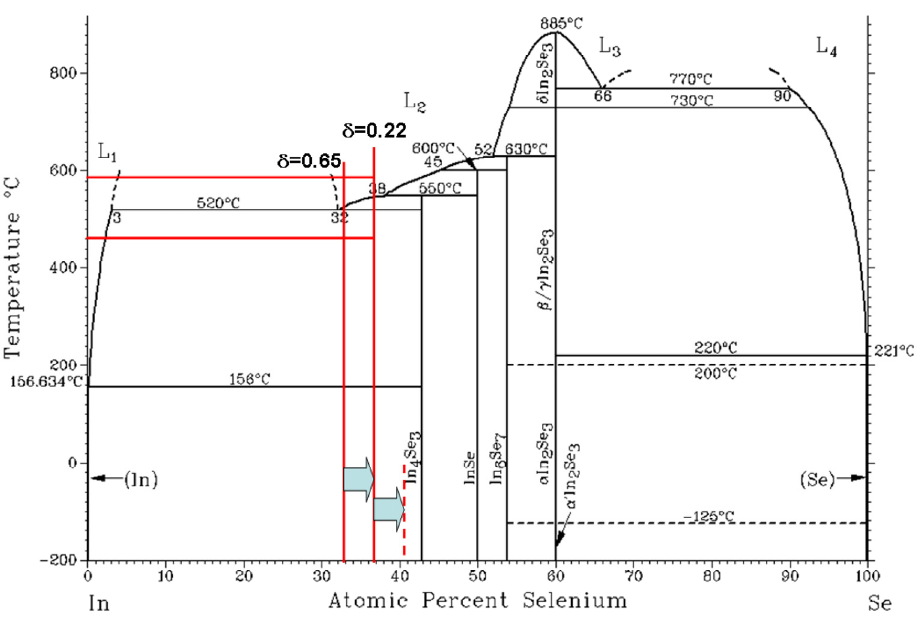
Figure 5. Binary phase diagram of In–Se. The starting compositions of grown crystals of In 4 Se 3 −δ ( δ = 0.65 and 0.22) are of In 67 Se 33 and In 63 Se 37 , respectively. Excess In as much as 4 at.% segregated at the top of the crystal ingots. Red horizontal line represents the melting (590 °C) and crystallizing temperature (460 °C) range of δ = 0.22 compound. Reproduced with permission from Nature publishing Group, 2009 [15].